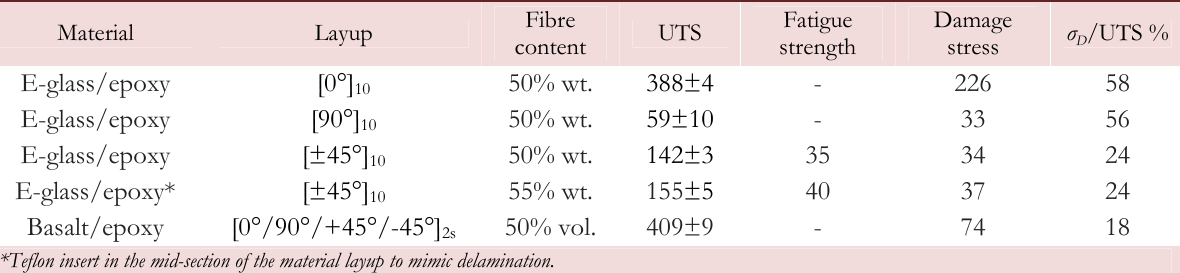
Table 1: Characteristics and mechanical properties of the tested materials. Damage stress is the average value among those obtained from the different thermographic methods, except for E-glass/epoxy [0°] 10 and [90°] 10 where only the static thermographic method has been